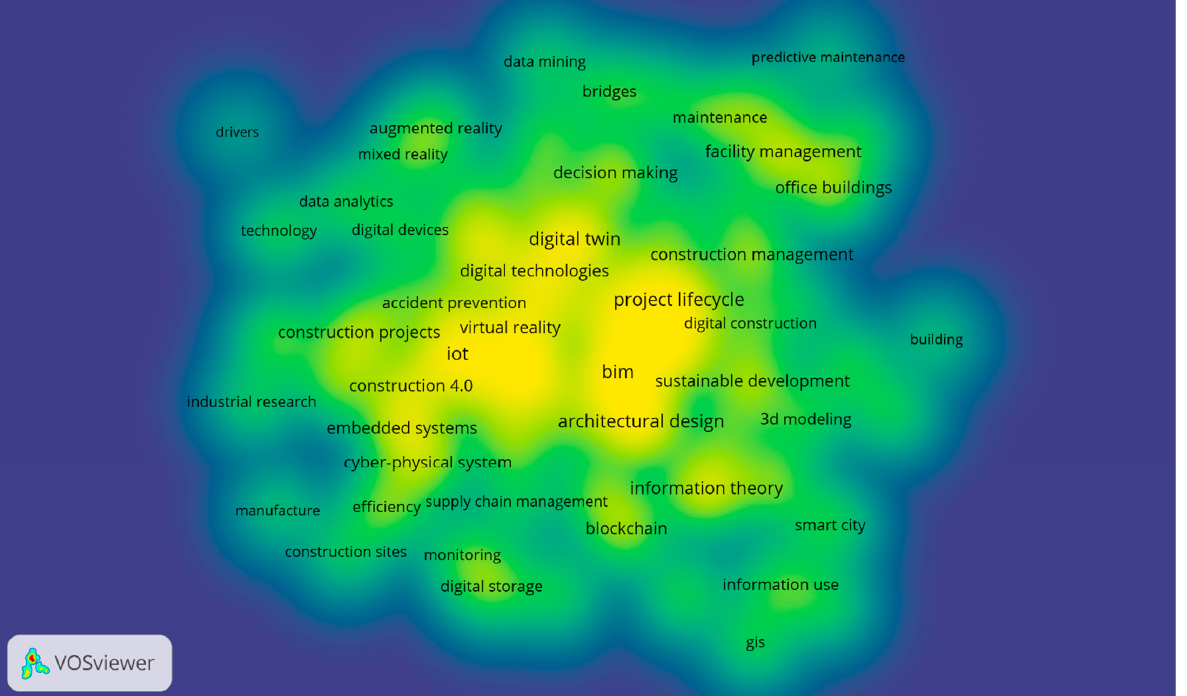
Figure 13. Items’ link density visualization performed with VOSviewer.